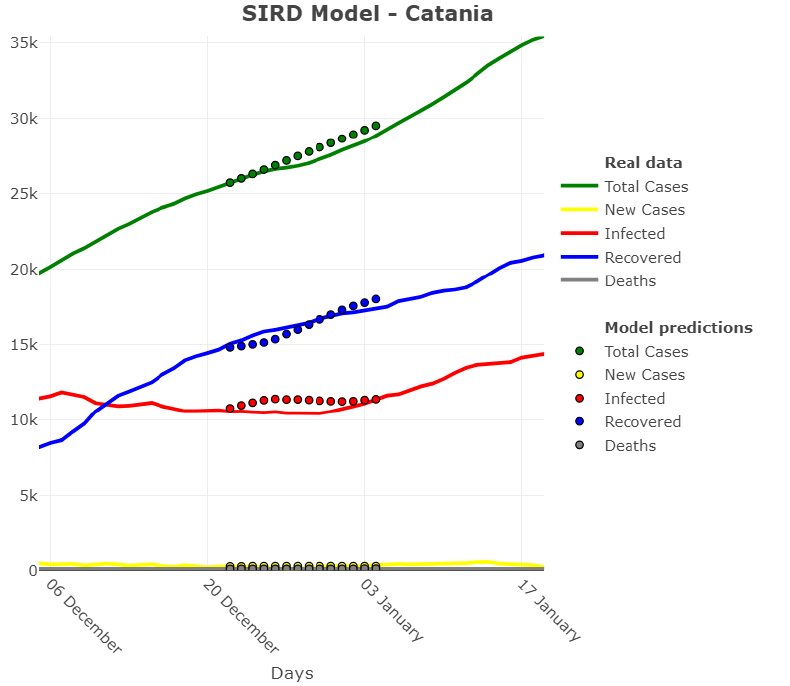
Figure 4. Adjusted SIRD model for Catania province—Forecast origin: 20 December